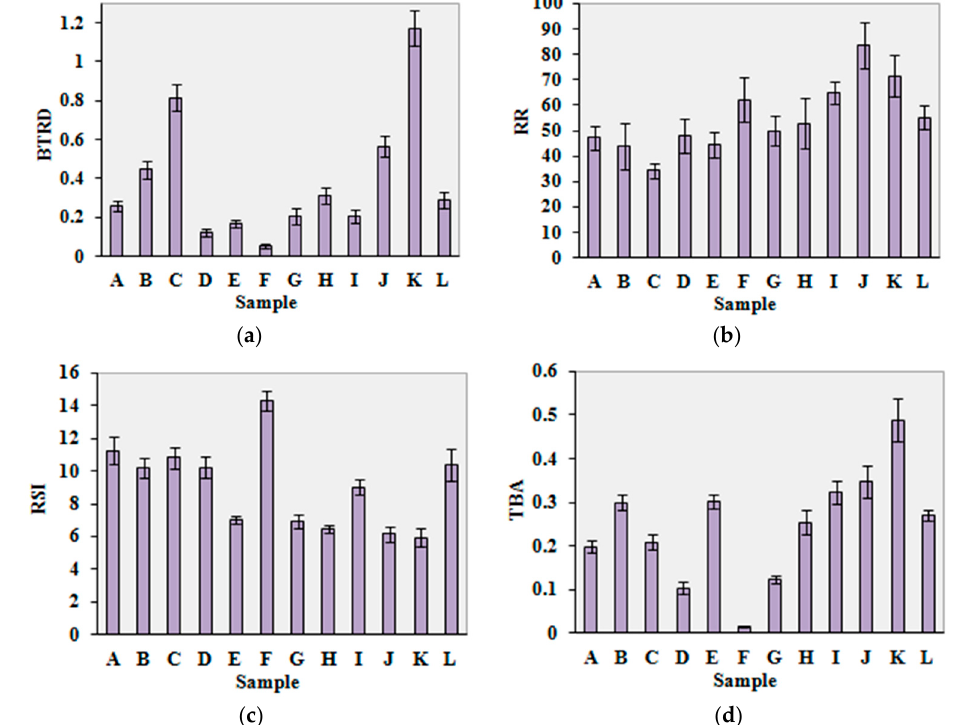
Figure 11. Bar charts of the test results, with bar errors for standard deviation: ( a ) bending and twisting rigidity descending (BTRD); ( b ) resilience ratio (RR); ( c ) relative smoothness index (RSI); ( d ) thermal buffering ability